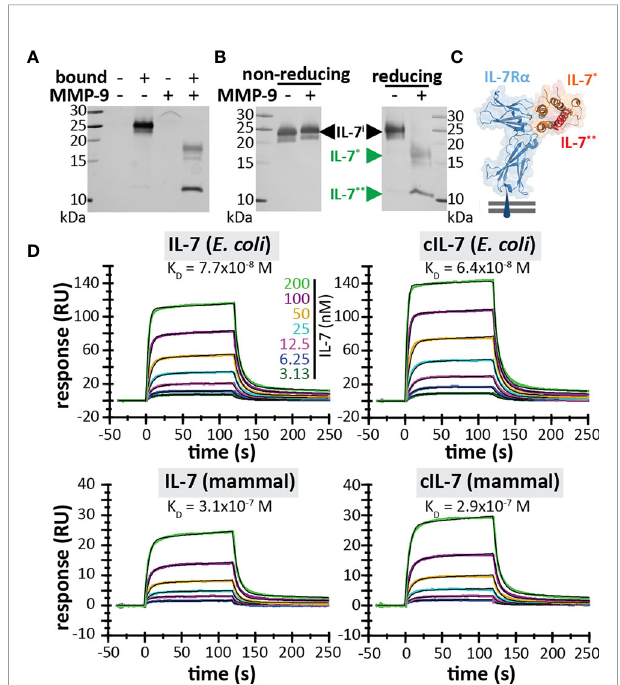
FIGURE 2 | IL-7 interaction with the IL-7 receptor remains intact upon cleavage by MMP-9. (A) His-tagged IL-7 (produced in insect cells) was subjected to histidine tag pull-down. Bead-bound proteins and non-bound proteins were resolved by reducing SDS-PAGE. (B) IL-7 in the presence (+) or absence (-) of MMP-9, subjected to non-reducing or reducing electrophoretic separation. (C) 3D model of the interaction between IL-7 and the IL-7R a (blue) [based on PDB structure 3DI3 (29)] with indication of the IL- 7 fragments generated by MMP-9 [IL-7* (orange) and IL-7** (red)]. (D) Binding of IL-7 [from E. coli (top) or mammalian cells (bottom)] and MMP-9-cleaved IL-7 (cIL-7, 1/100 molar ratio MMP-9/IL-7, 4h at 37°C) to rhIL-7R a , as analyzed by SPR (results representative for 2 experiments, see Supplementary Figure 3 ). Colors represent different concentrations of IL-7 as indicated and black lines represent curve fi ts with a two-state reaction model (IL-7-IL-7R a ) according to McElroy et al.